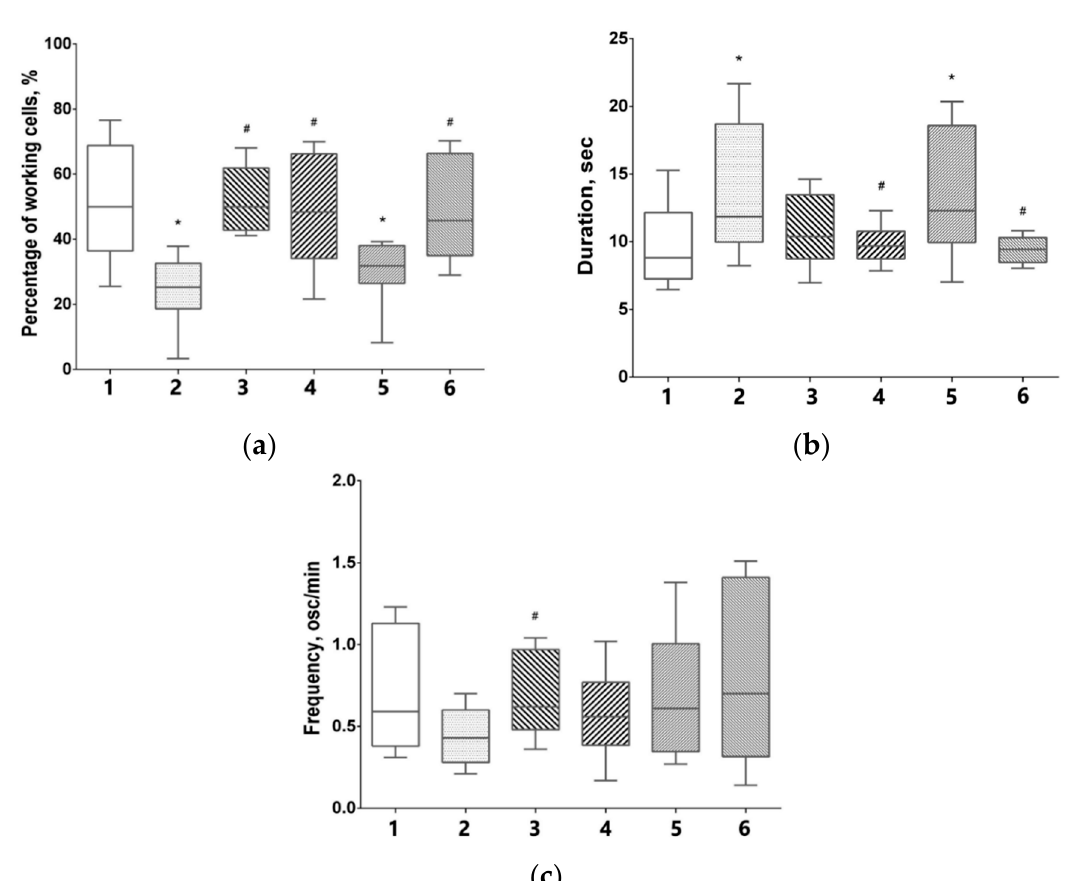
Figure 5. Key parameters of spontaneous Ca 2+ activity in primary hippocampal cultures on day 7 of neuradapt post ‐ treatment: 1 ‐ Intact; 2 ‐ Hypoxia; 3 ‐ Hypoxia and neuroadapt 1 μ M, immediate treatment; 4 ‐ Hypoxia and neuradapt 15 μ M, immediate treatment; 5 ‐ Hypoxia and neuradapt 1 μ M, post ‐ treatment; 6 ‐ Hypoxia and neuradapt 15 μ M, post ‐ treatment. ( a ) The relative number